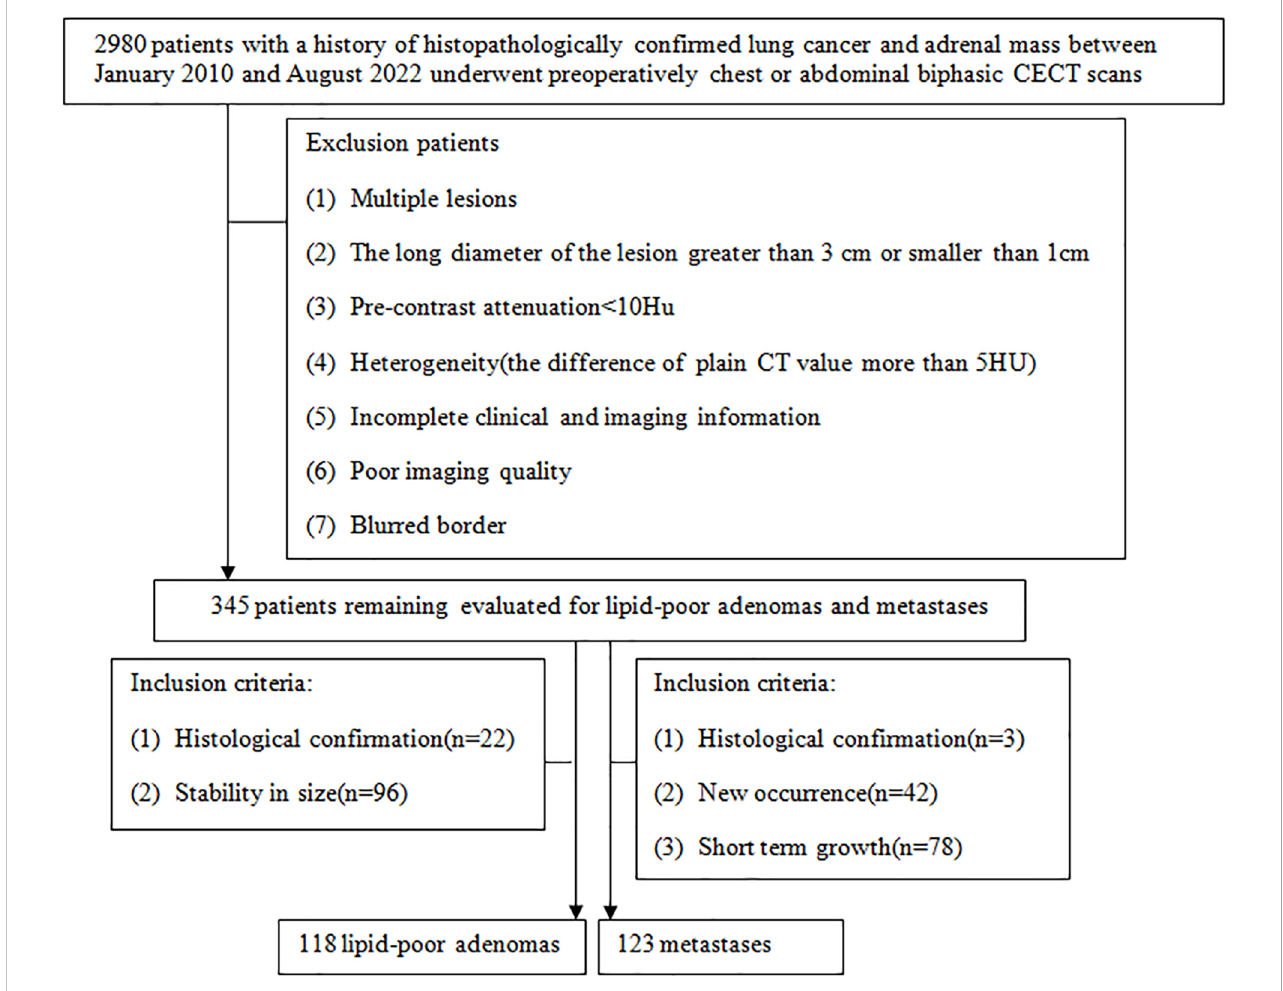
FIGURE 1 Flowchart shows the patient selection process, along with the inclusion and exclusion